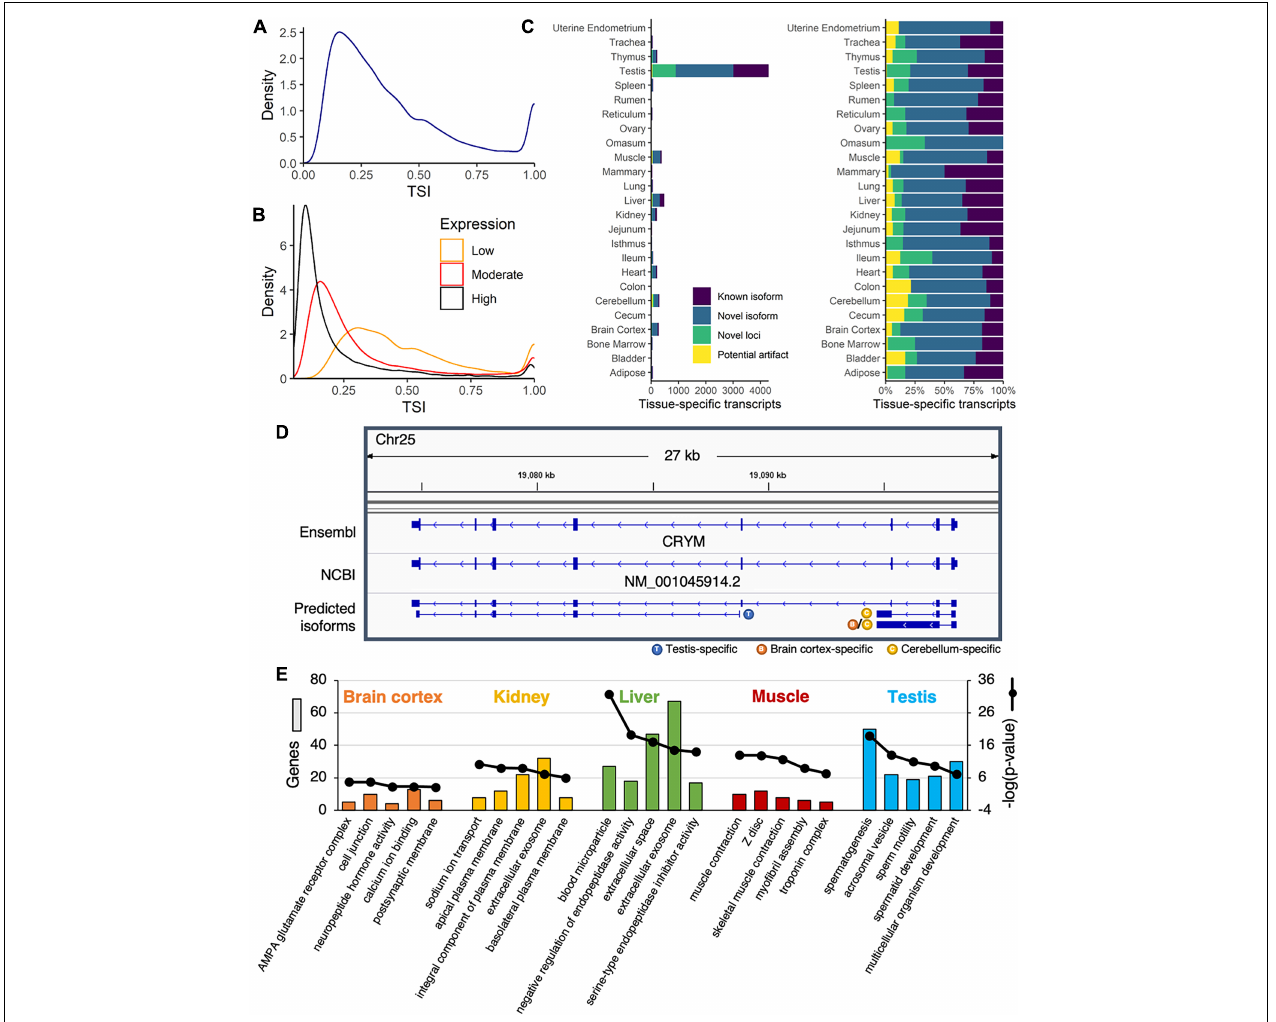
FIGURE 3 | Identification of tissue-specific isoforms. (A) Density plot of the tissue-specificity index (TSI) identified for each predicted transcript, based on average transcripts per million (TPM) in each tissue. (B) Density plot of TSI for predicted transcripts with low (average TPM < 1), moderate (1 ≤ average TPM < 10), or high expression (average TPM ≥ 10). (C) Number of tissue-specific transcripts (TSI ≥ 0.8) attributed to each tissue, categorized as known or novel isoforms, novel loci, or potential artifacts. (D) The annotated transcript at the CRYM locus was expressed across a range of tissues, whereas novel isoforms were either testis- or brain-specific. (E) Functional enrichment of genes corresponding to tissue-specific isoforms in brain cortex, kidney, liver, muscle, and testis. Top five most significant gene ontology terms reported (Benjamini corrected p -value < 0.05).